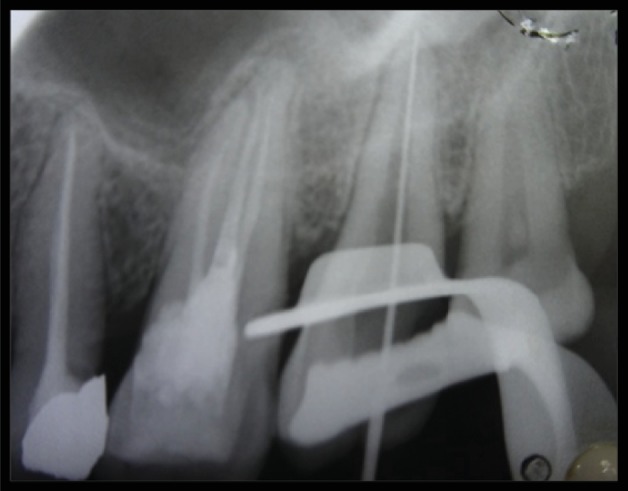
Working length IOPA.